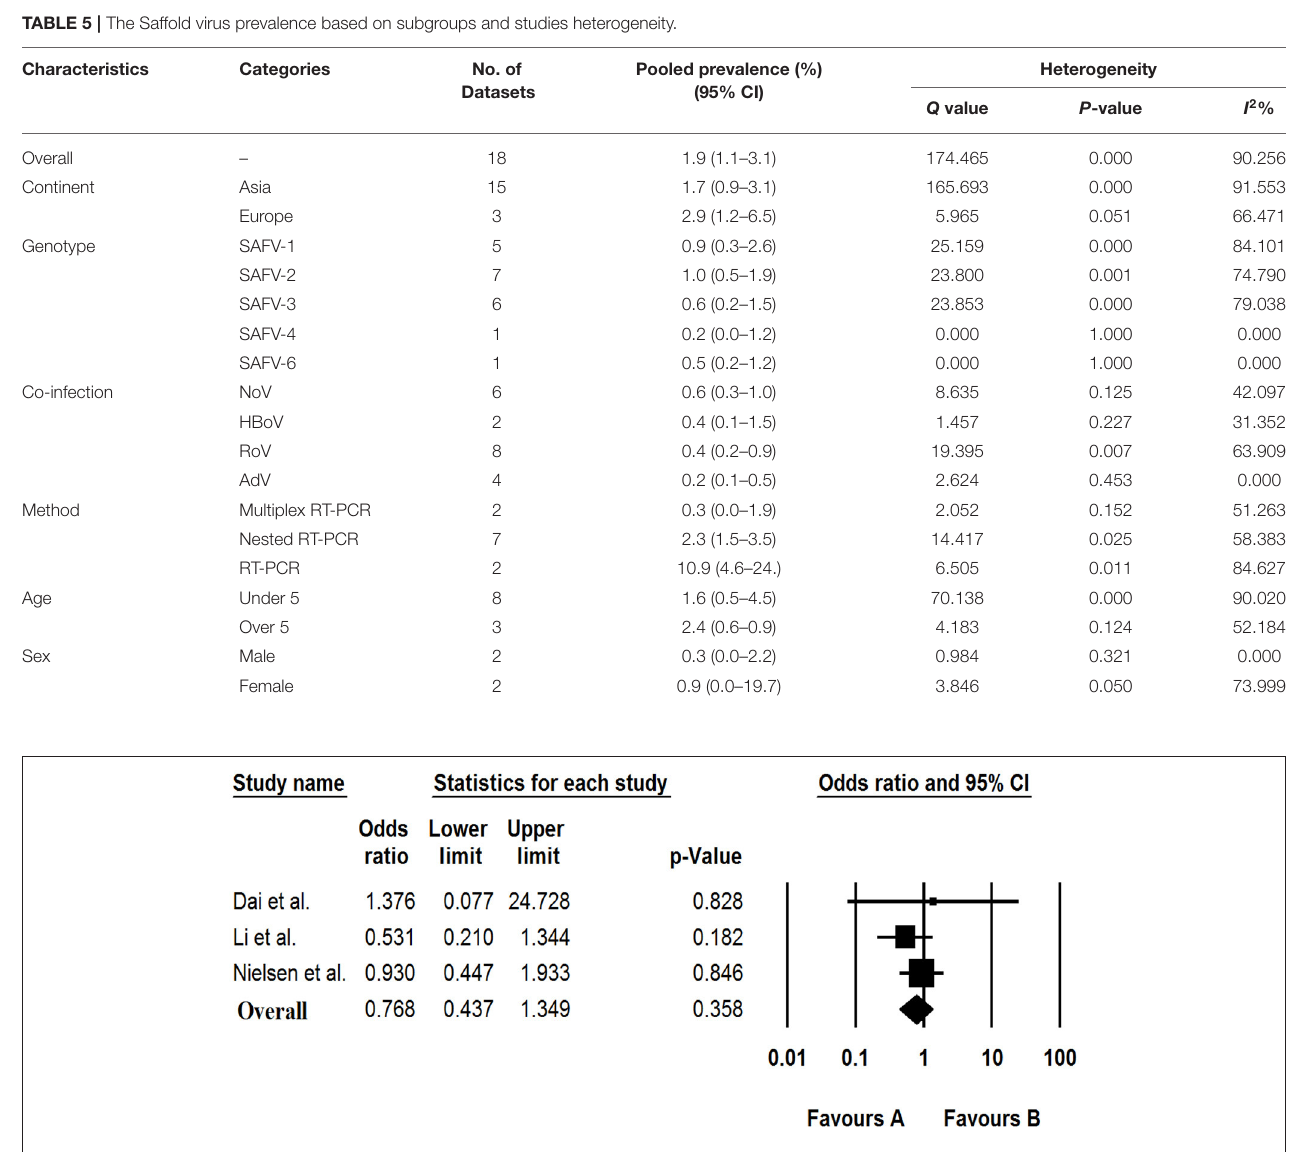
who are BuV infected. Contrastingly, RoV infection was more frequent in patients infected with BuV than SAFV. Similarly, AdV infection was more common in patients with BuV than SAFV infection. EVs have the highest proportion of co-infection with HCoSV followed by AdVs, RoVs, and NoVs. The high rate of co-infection with classic enteric viruses may indicate the role of these viruses in causing symptoms in patients infected with these newly discovered viruses (6, 46). The other possible point that is against the pathologic role of these viruses in the development of GE is the low viral load in patients with GE, which might be due to transient infection and the lack of replication in the gastrointestinal tract (44). Also, the high presence of these viruses